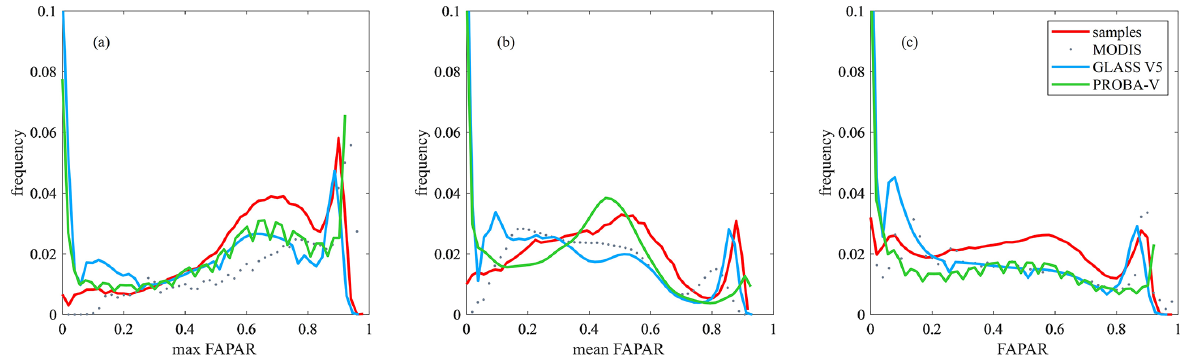
Figure 2. Histogram distribution of the FAPAR values (bin width of 0.02) of the 2014–2018 time series of fused FAPAR samples for the representative pixels and of the MODIS, PROBA-V, and GLASS V5 FAPARs for the global land pixels: (a) max FAPAR is the distribution of the maximum FAPAR values of the 2014–2018 time series, (b) mean FAPAR is the distribution of the mean FAPAR values of the 2014–2018 time series, and (c) FAPAR is the distribution of all of the FAPAR values of the 2014–2018 time series.